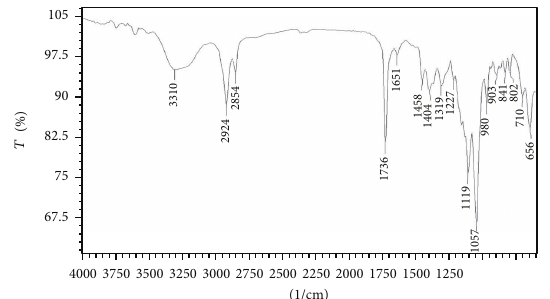
Figure3:FTIRabsorptionspectraofpartiallypurifiedbiosurfactant produced by strain